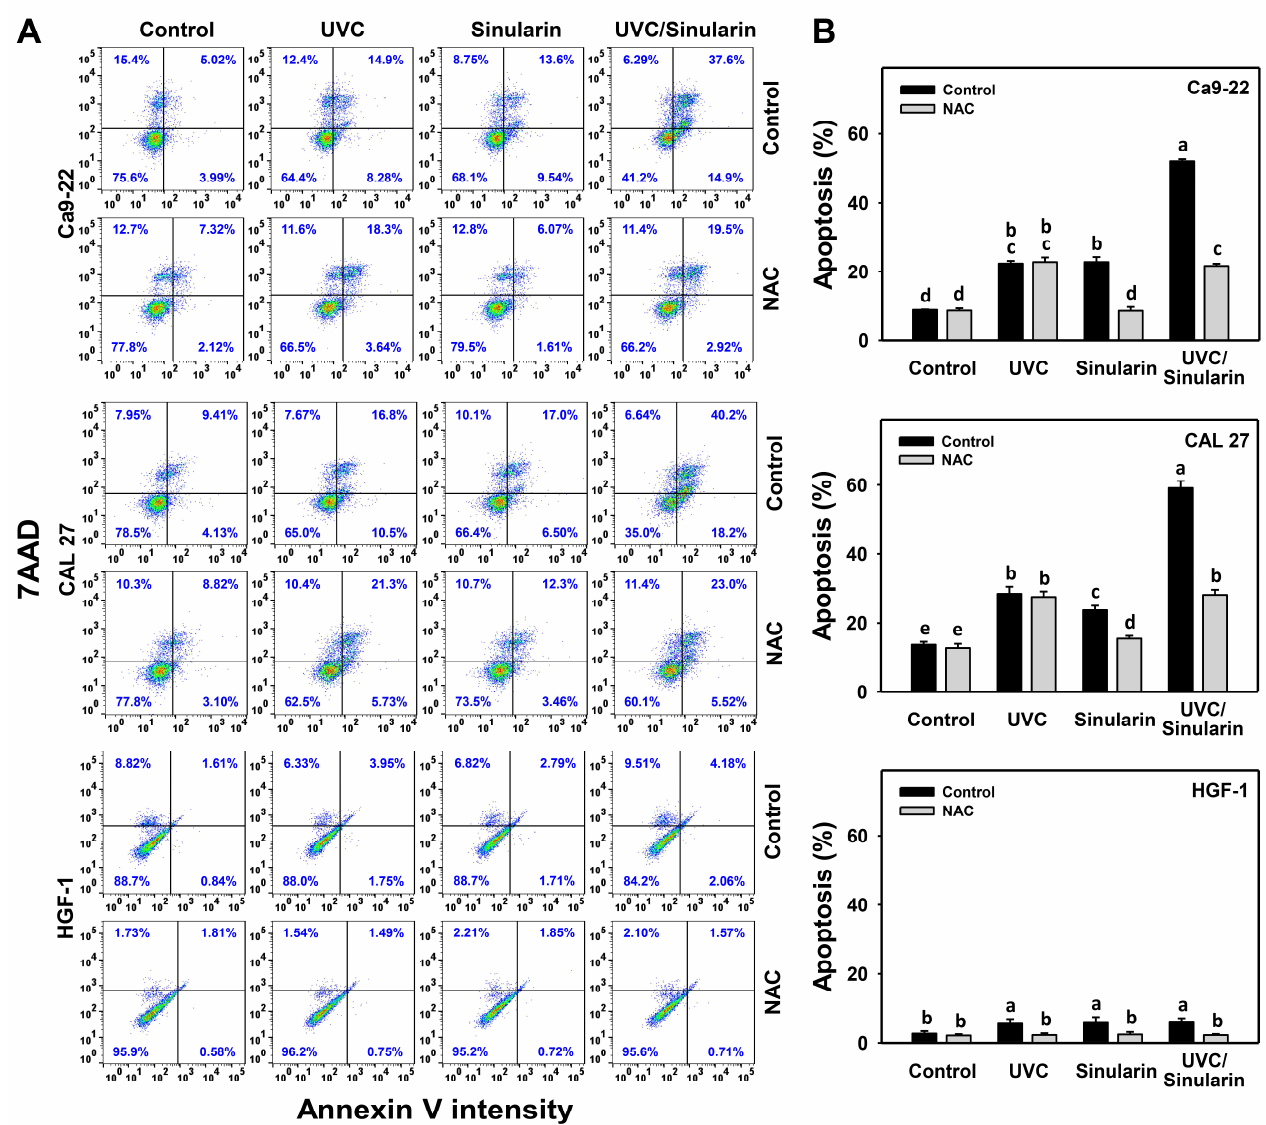
Figure 3. Annexin V-detected apoptosis assays of UVC and/or sinularin treatments. Following the NAC preincubation (5 mM for 1 h) or not, the cells were arranged into four kinds of treatments: the control (0.1% DMSO in medium), UVC, sinularin, and UVC/sinularin for 48 h. The UVC and/or sinularin conditions were 12 J/m 2 , 2 μM and 10 J/m 2 , 3 μM for oral cancer cells (Ca9-22, CAL 27), and 12 J/m 2 , 3 μM for normal cells (HGF-1) for 48 h, respectively. ( A , B ) Patterns and quantifications for annexin V/7AAD analysis. The apoptosis (%) is annexin V-positive (%). For multi-comparisons, the treatments marked without repeated characters (a to e) differ significantly ( p < 0.05). The data were plotted as the mean ± SD ( n = 3).